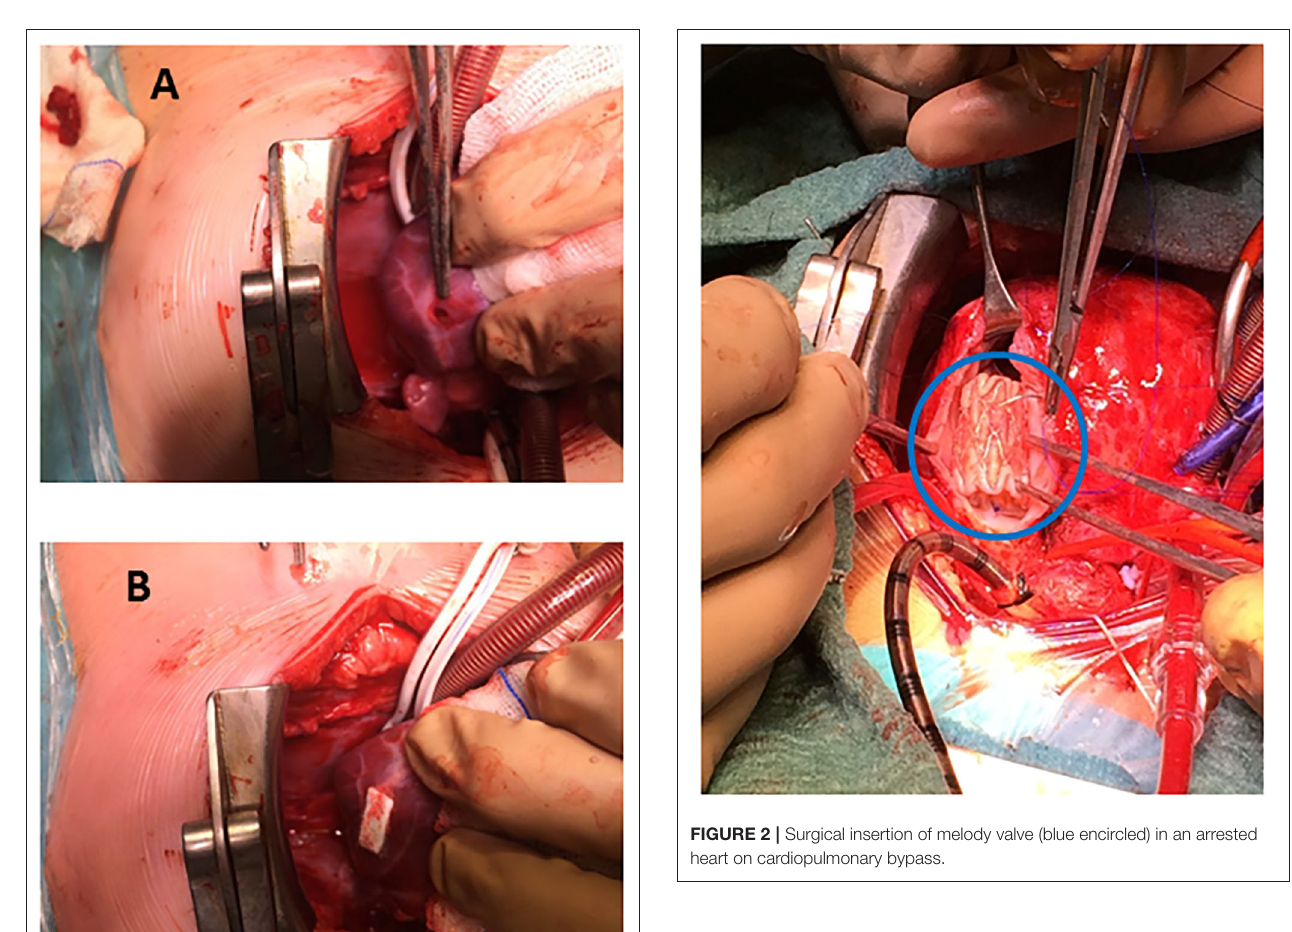
branch ballooning/stenting either before or after surgery